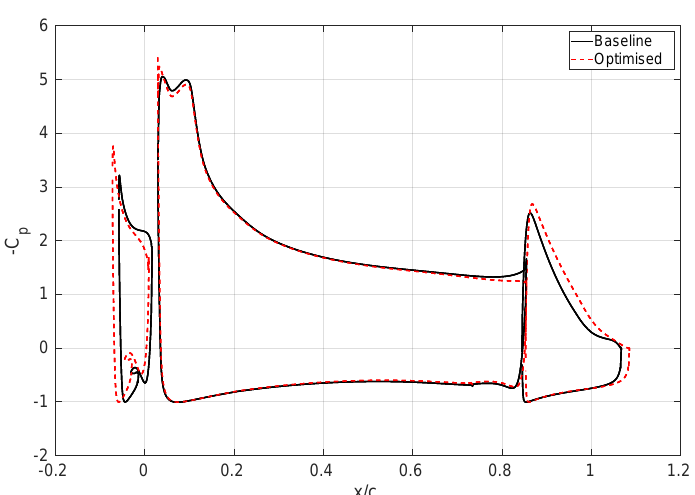
Figure 16. Surface C p distribution for the baseline and optimised